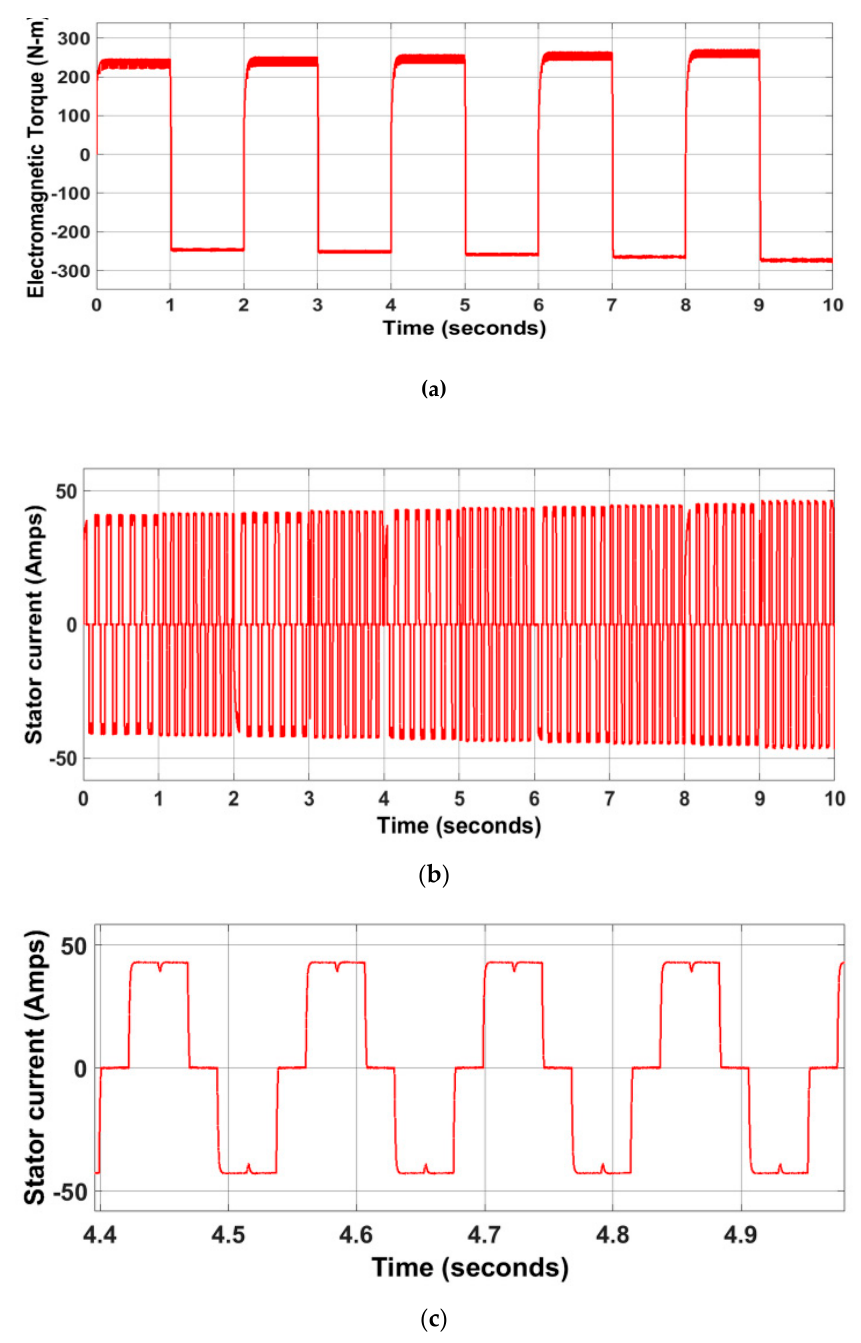
Figure 17. ( a ) Electromagnetic torque developed by a motor using the parameters of 12L14 HR steel; ( b ) stator current in Phase A of a motor using the parameters of 12L14 HR steel; ( c ) expanded waveform of stator current in Phase A of motor corresponding to 12L14 HR steel.